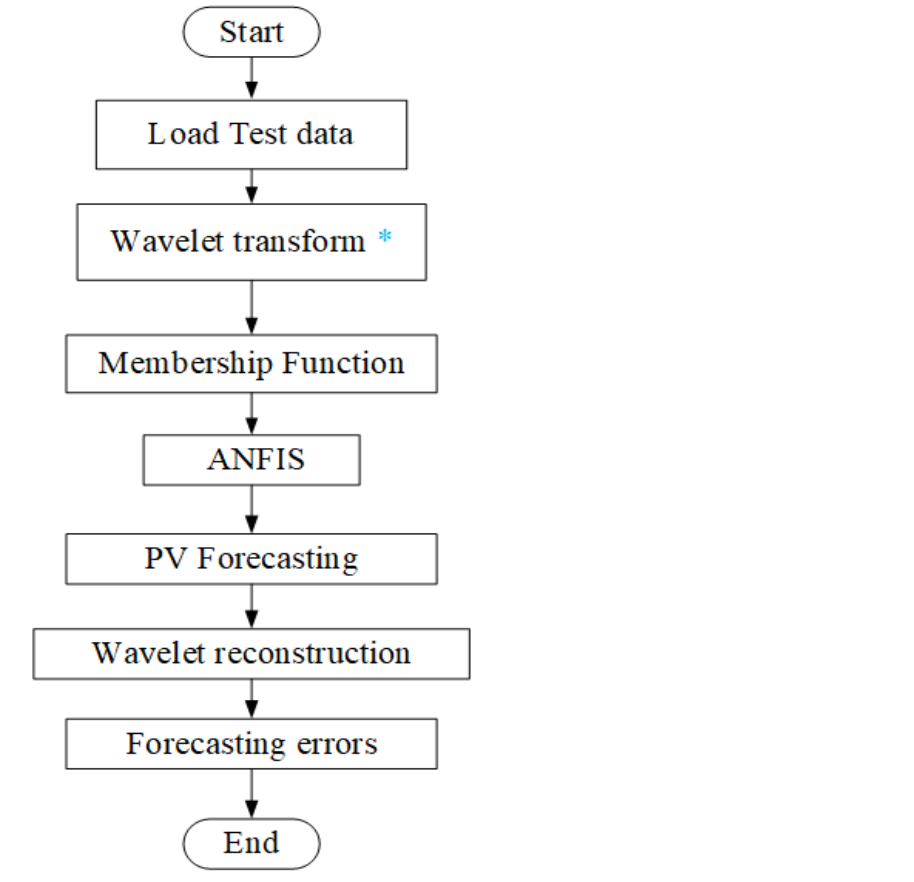
Figure 4. Wavelet-ANFIS training flowchart.